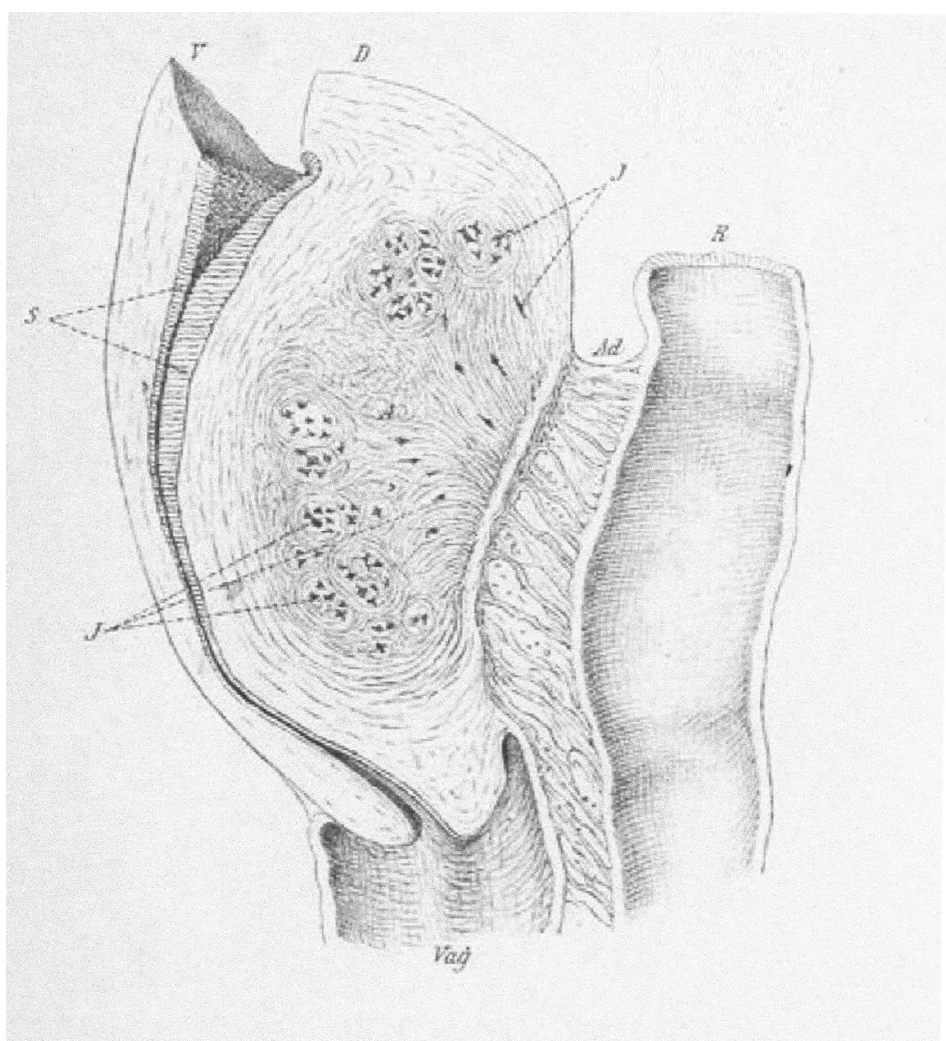
Figure 1. A median section of a hypertrophic uterus with adenomyosis in the posterior wall (D) but not affecting the anterior wall (V). Von Recklinghausen describes adenomyosis as a kidney-shaped adenomyoma containing glandular islets (J). There were adhesions (Ad) to the rectum (R). The endometrium (S) and the vagina (Vag) are shown. From von Recklinghausen (1896).